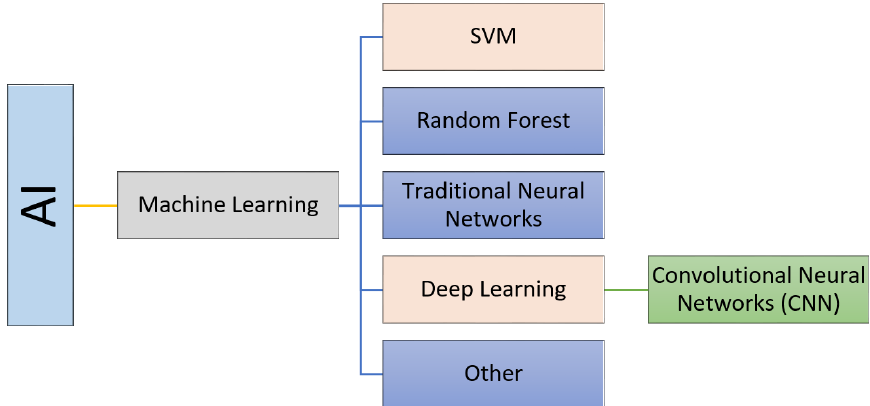
Figure 4. Components of artificial intelligence (AI).